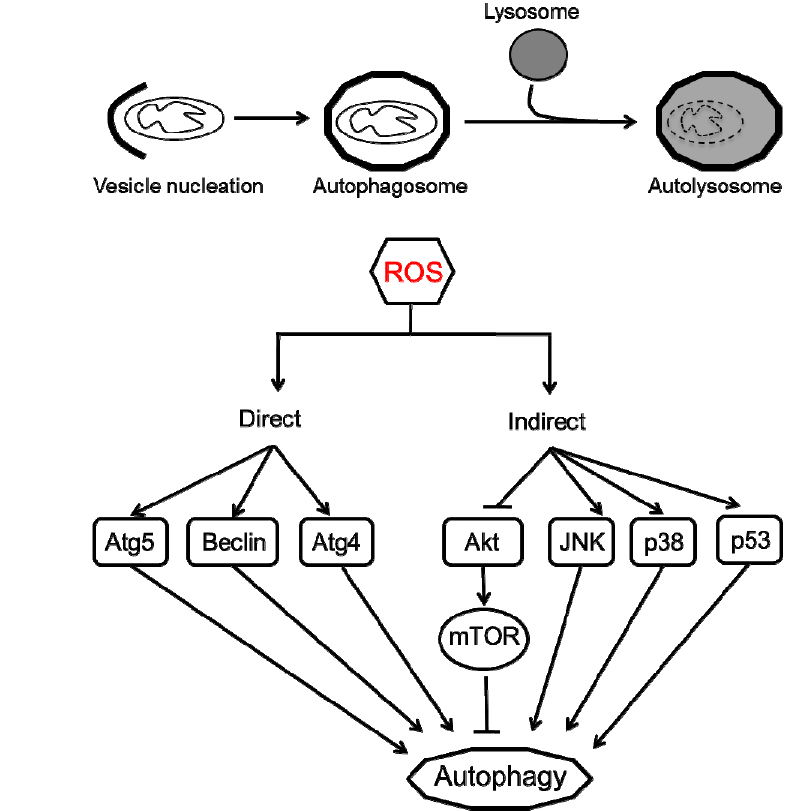
Figure 2. Autophagy process and regulation by ROS. ( A ) Autophagy begins with vesicle nucleation where the damaged organelles (mitochondria) are sequestered to form an autophagosome. This vesicle fuses with the lysosome to form an autolysosome where the contents are degraded by lysosomal hydrolases and nutrients are recycled to the cytoplasm; ( B ) ROS can regulate autophagy in two ways: direct and indirect. Direct regulation involves modification of key proteins involved in the autophagy process including Atg4, Atg5 and Beclin. Indirect regulation by ROS involves alteration of signaling pathways such as JNK, p38 that can induce autophagy. On the other hand, ROS may inhibit Akt signaling and downstream mTOR and thereby induce